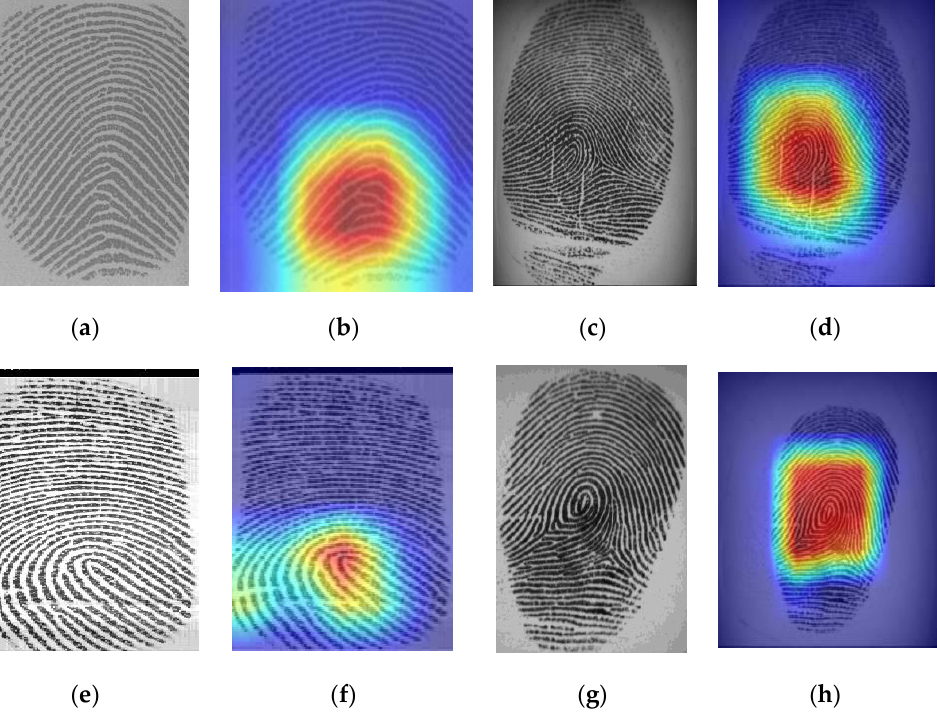
Figure 8. Visualizations of activation maps using the GradCam method for four samples from different classes of FingerPass dataset: ( a ) arches finger; ( b ) arches’s gradcam; ( c ) left loop finger; ( d ) left loop’s gradcam; ( e ) right loop finger; ( f ) right loop’s gradcam; ( g ) whorls finger; and ( h ) whorls gradcam.